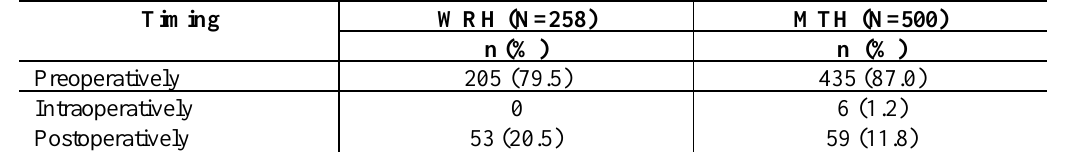
Fig. 1 : Comparison of length of Stay of different surgeries in two hospitals. Table III : Time of Antibiotic Prophylaxis